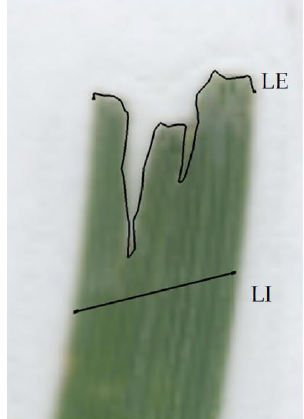
Figure 1. Leaf tip damage level = 3.50.